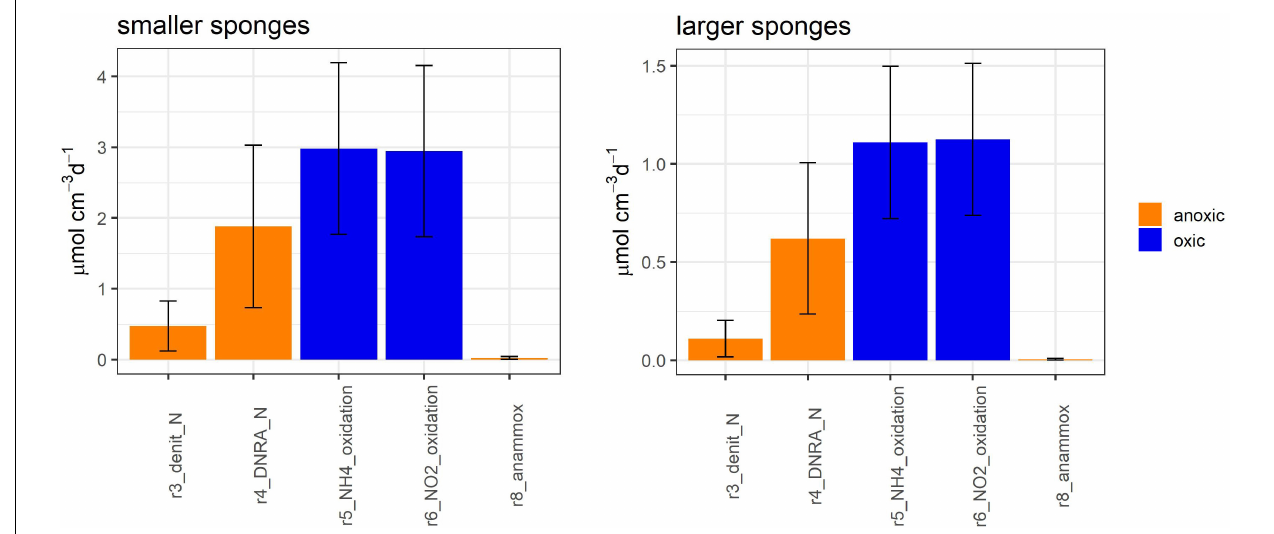
FIGURE 4 | Model-calculated metabolic aerobic (blue) and anaerobic (orange) nitrogen-transforming fluxes in smaller Geodia barretti individuals (left) and larger G. barretti individuals (right). The reaction numbers refer to Figure 2 and Table 2 .